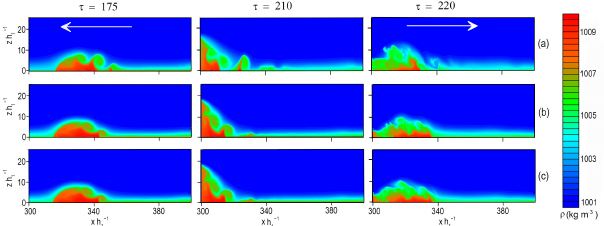
Figure 9. Comparison of the density snapshots during collision of ISWs in case (A13; A13) for different Schmidt numbers. (a) Sc = 1. (b) Sc = 10. (c) Sc = 1000. The right half of the numerical flume is shown due to the symmetry of the interaction